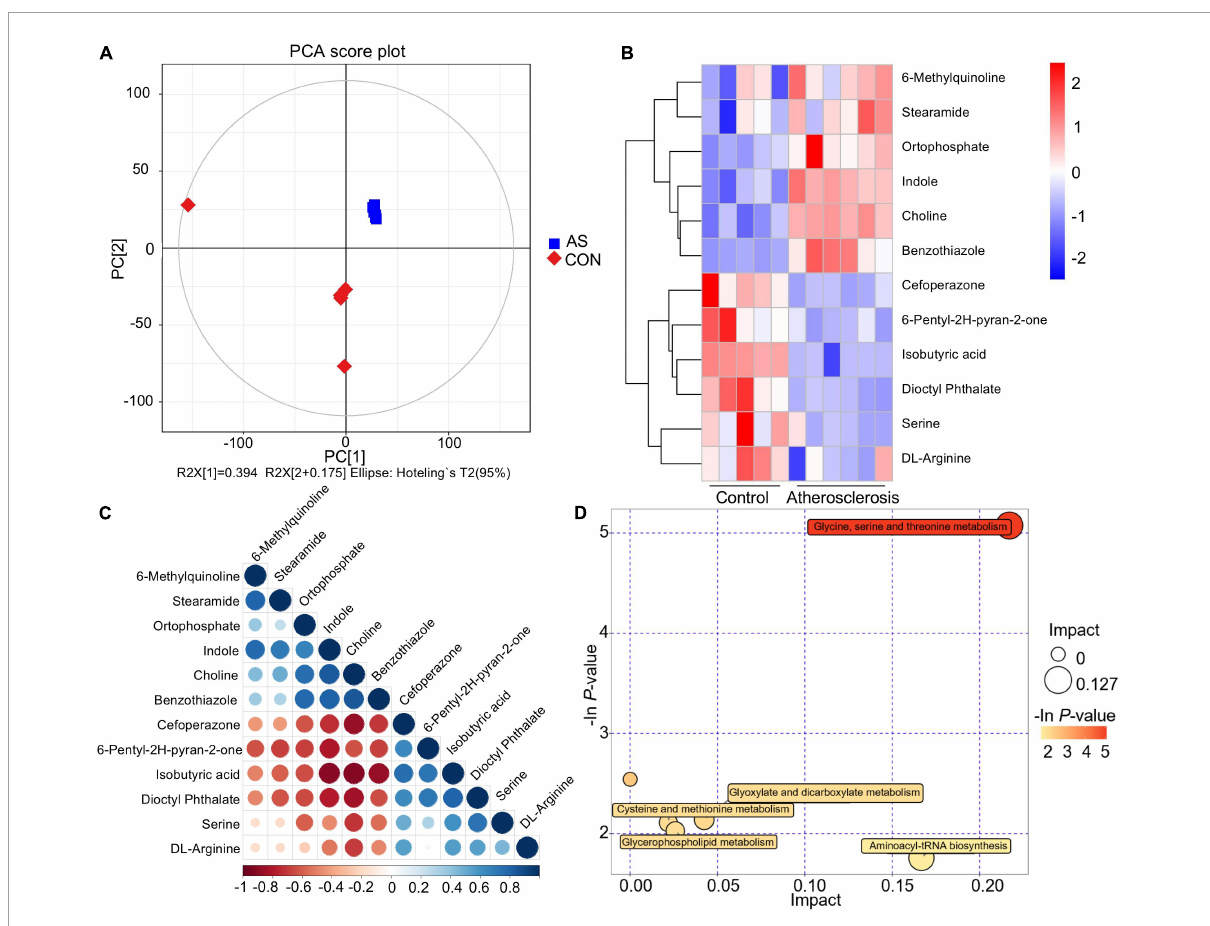
FIGURE4 Differential metabolites and key metabolic pathways of atherosclerotic lesion. (A) Principal component analysis score plots. (B) Heatmap of the differential metabolites. (C) Associations between the differential metabolites. (D) Bubble plot of pathway enrichment